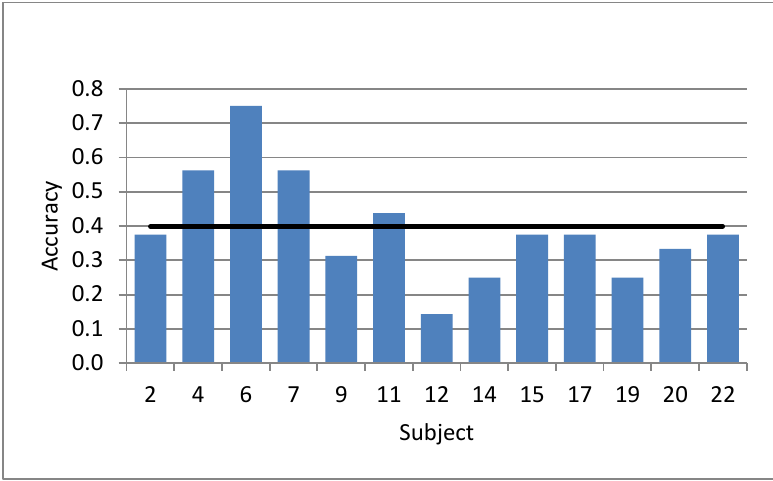
Figure 8. Perception accuracy in L3 German for rhotics at T2.